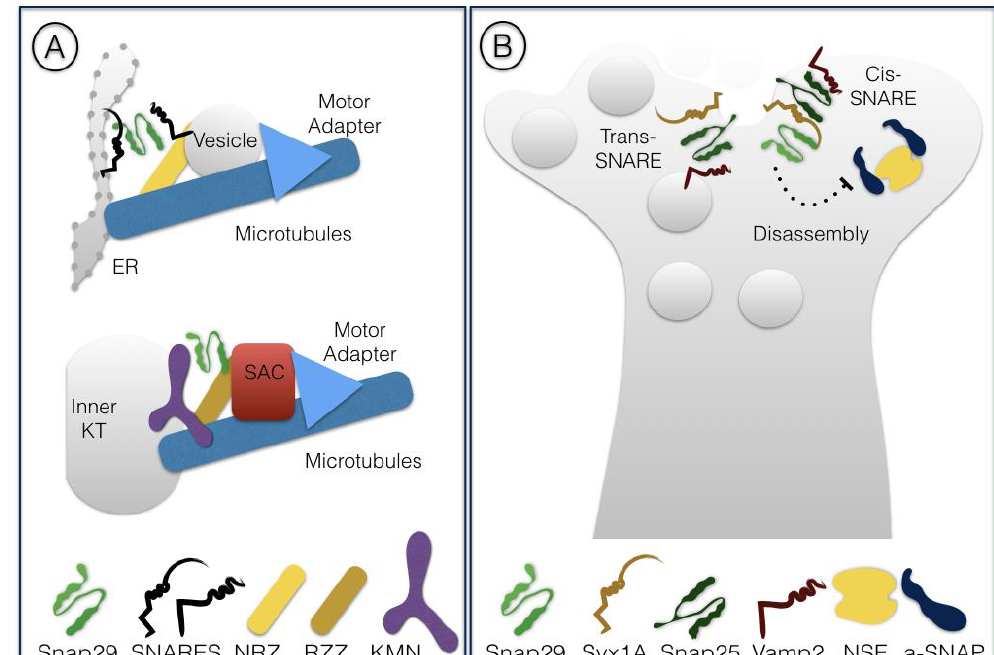
FIGURE 5 : Non ca- nonical roles of Snap29. Schematic representation of the function of Snap29 at synaptic vesicles (A) and at the kinetochore (B) . The comparison in A illustrates similarities between membrane membrane-indepen- dent process of ki- netochore for- mation. The regula- activity of SNAP29 during syn- aptic transmission illustrated in B is likely to involve binding to SNARE bundles containing SNAP25 (see text for